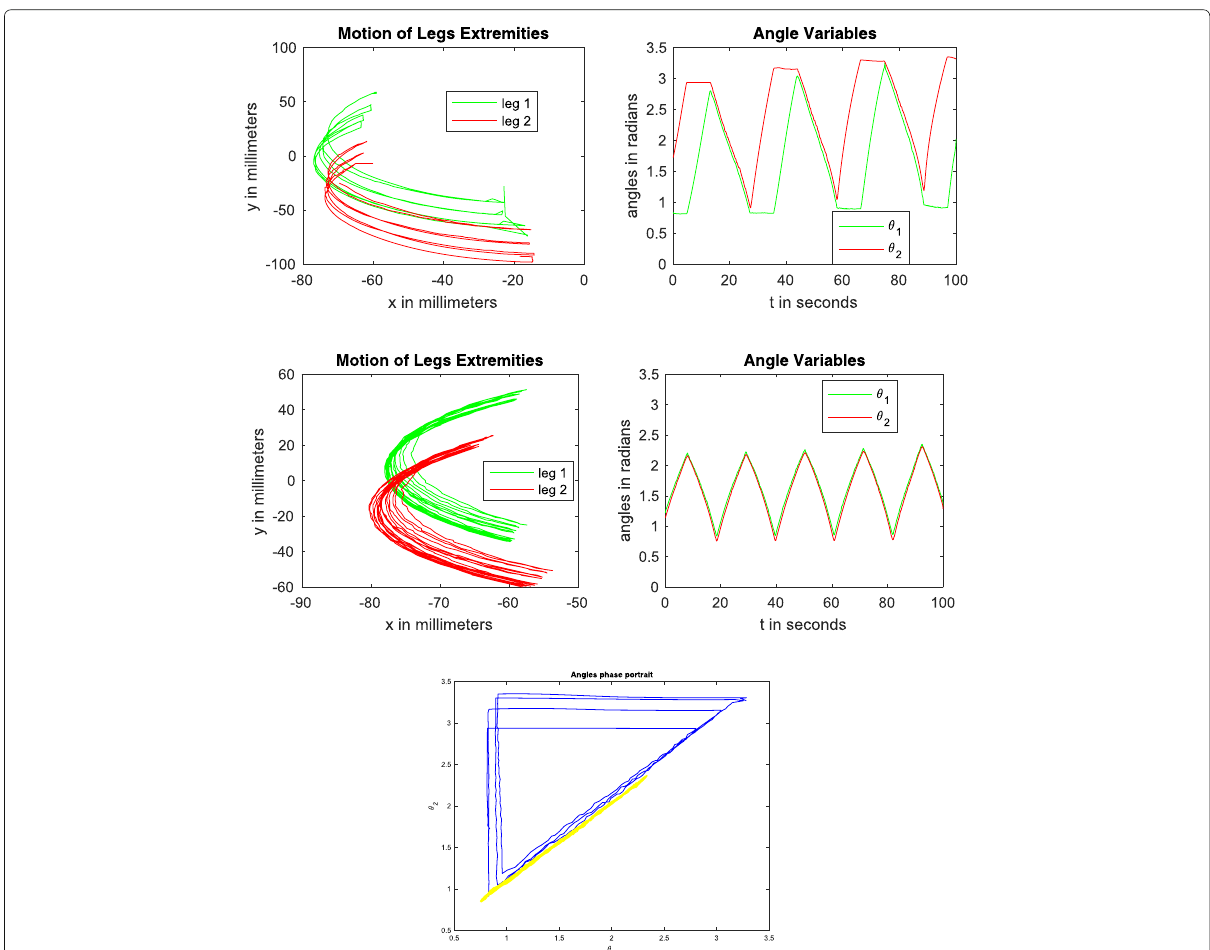
Fig. 26 Top two pictures correspond to the decoupled motion and the bottom ones to the coupled motion. The left pictures describe the two curves followed by the extremity of each leg for three and a half strokes. As expected they follow a parabolic motion in both cases. For the decoupled motion they are shifting throughout the trajectory due to the displacement of the copepod. The right pictures depict the angular variables. The top one displays very clearly the decoupled motion for half of the stroke and then both legs coming back together, while the middle pictures depict the fact that both legs moves together throughout the entire motion. The bottom picture shows the strokes within the abnormal triangle T . The decoupled motion is in blue and the coupled one in yellow